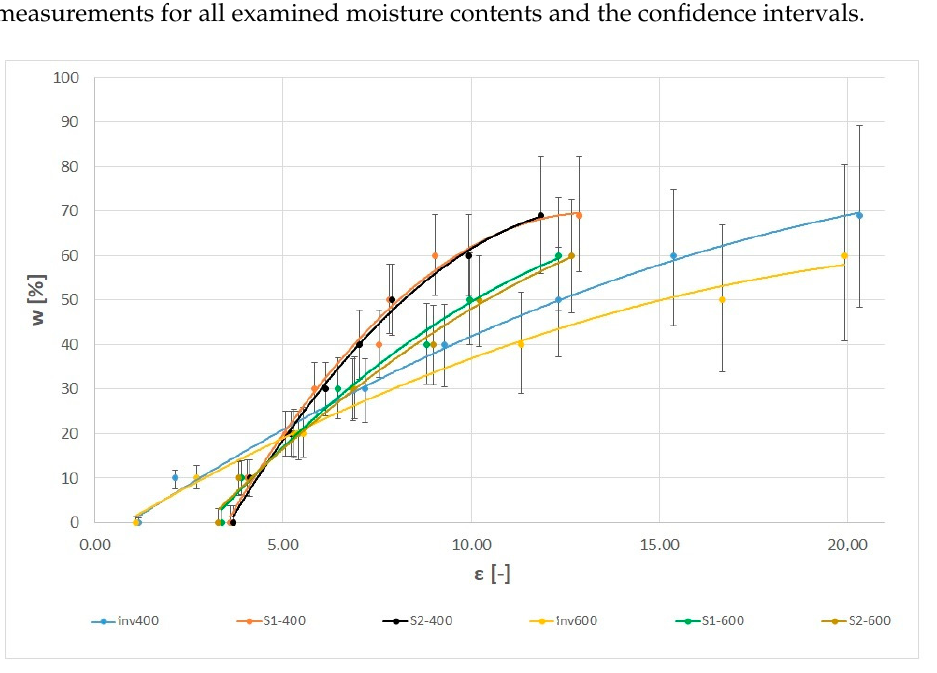
Figure 4. Relationship between the apparent permittivity reads determined with the use of the FP/mts invasive probe and the non-invasive probe and the moisture content of class 400 c.c. and 600 c.c.